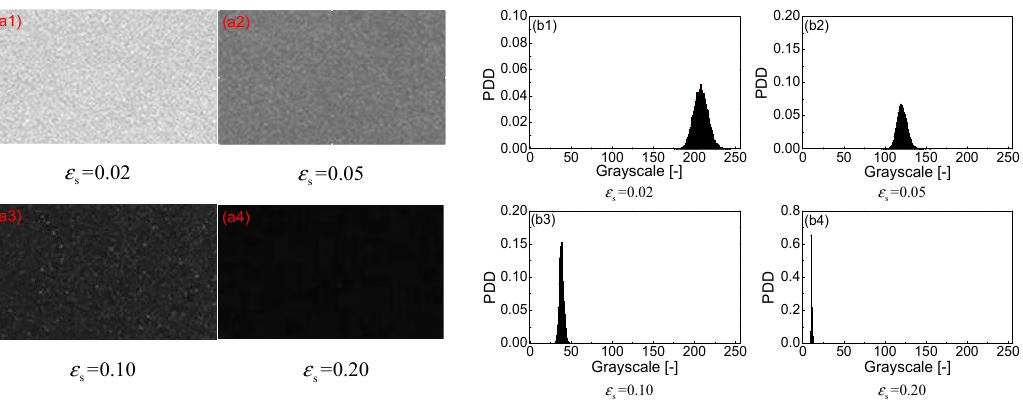
Figure 4. Particle image under different solids holdups for Group A FCC particles. The calibration curve of the graded solids holdup and the mean gray value of the respective digital images for FCC particles are shown in Figure 5. The solids holdup is well correlated with the gray values: the exponential correlation between the solids holdup ( ε s ) and grayscales ( G ) is obtained with an adjusted R square of 0.993.